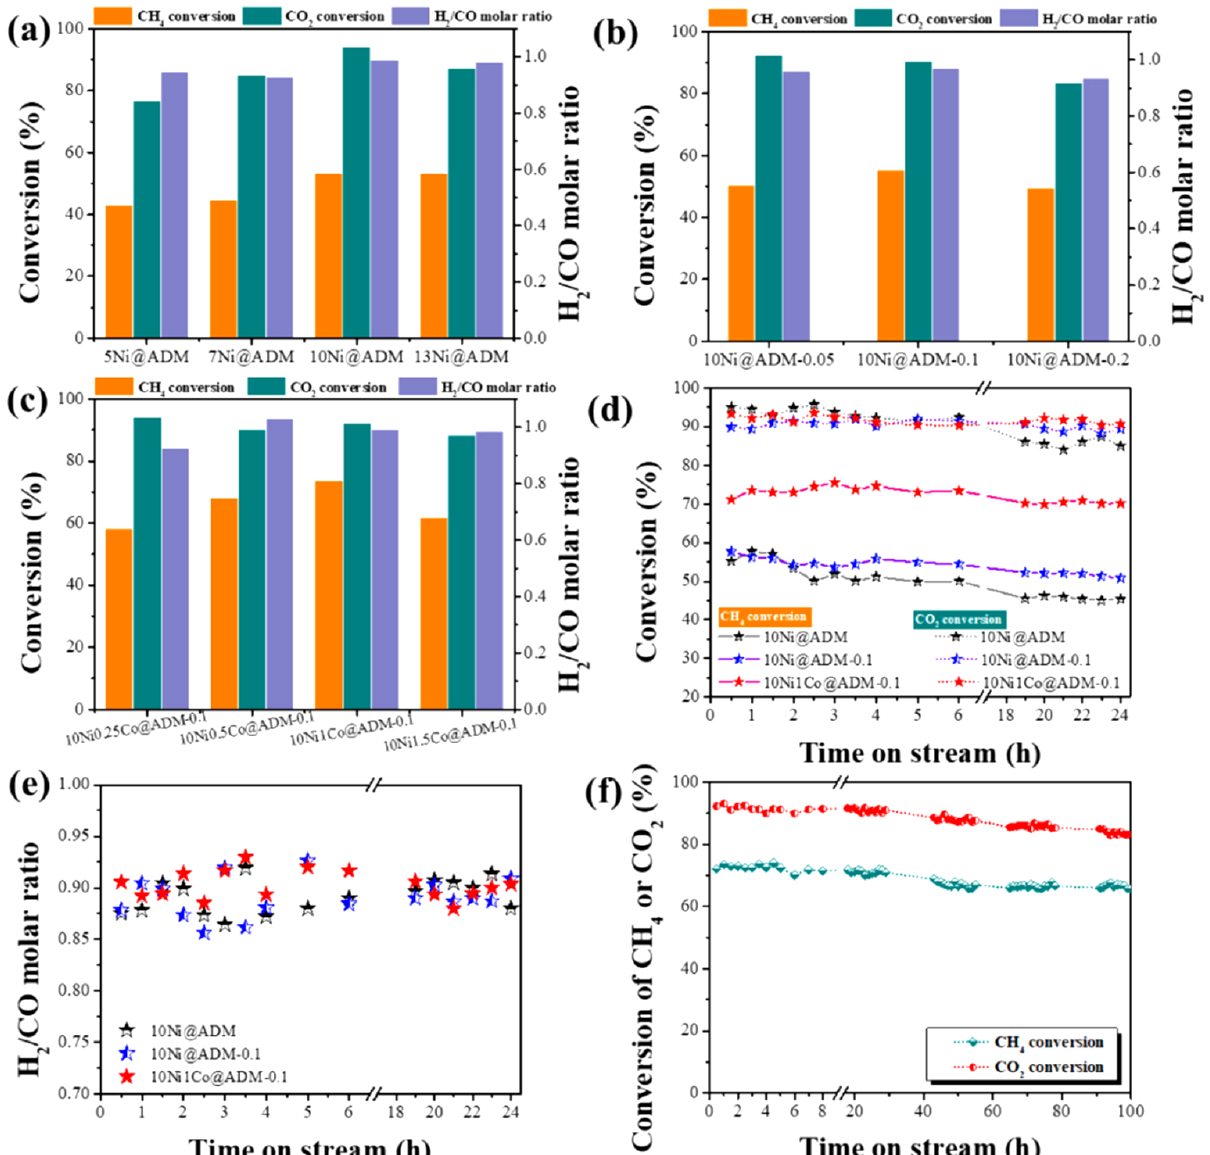
Figure 11. Dry reforming of methane reactions for 4 h over the ( a ) xNi@ADM (x = 5 – 13), ( b ) 10Ni@ADM-y (y = 0.05 – 0.2), and ( c ) 10NizCo@ADM-0.1 (z = 0.05 – 1.5) catalysts. ( d ) Conversions of CH 4 and CO 2 and ( e ) H 2 /CO molar ratio on the attapulgite-derived MFI (ADM) zeolite-encased Ni-Co alloys. ( f ) Dry reforming of methane reactions for the 100 h test over the 10Ni1Co@ADM-0.1 catalyst. Reproduced from [81]. Copyright (2023), with permission from Elsevier.